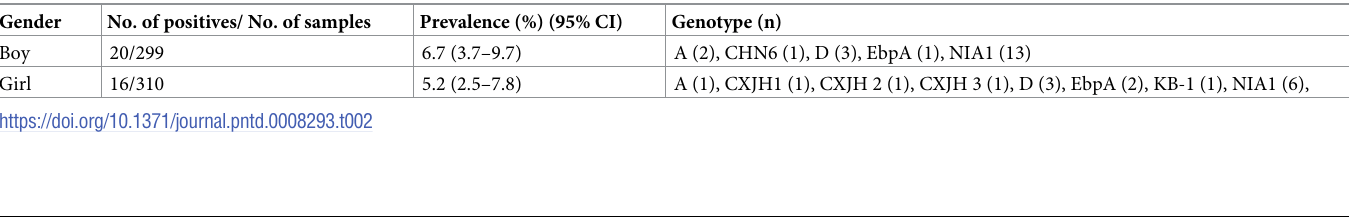
Table 2. Prevalence and genotype distribution of E . bieneusi among children in southern Xinjiang by gender. Gender No. of positives/ No. of samples